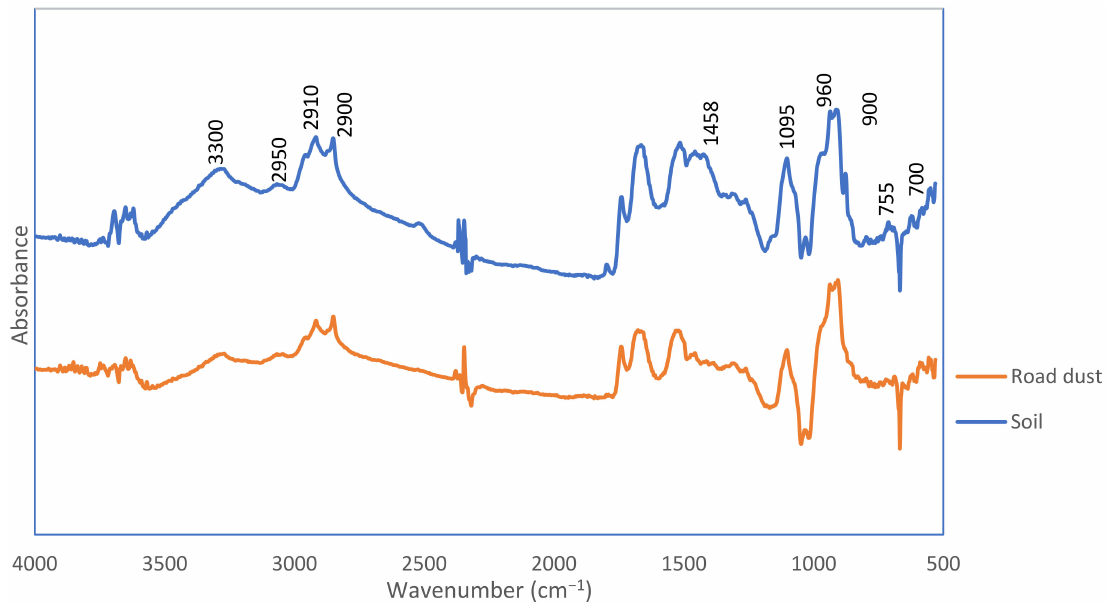
Figure 6. FTIR spectra of black fragments detected in soil and road dust